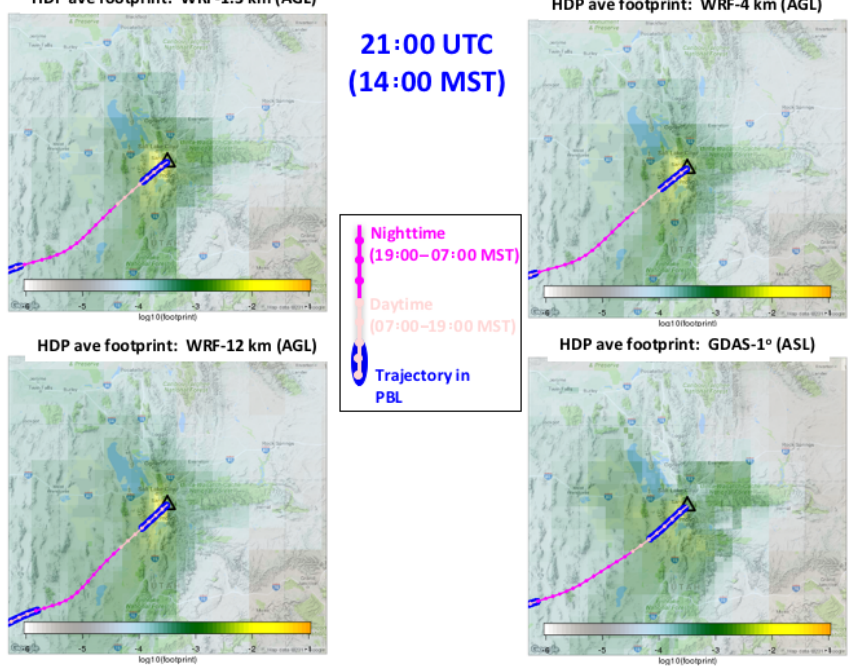
Figure 6. Similar to Fig. 5, but for the afternoon: 14:00MST (21:00UTC) at HDP.